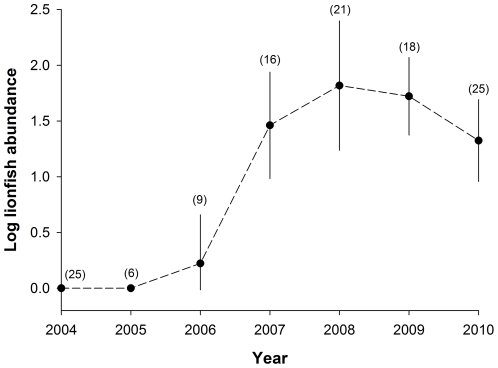
The abundance of Indo-Pacific lionfish (Pterois volitans and P. miles) on coral reefs off southwest New Providence, Bahamas.Abundance is the number of lionfish sighted during each roving survey, recorded in log10 scale. Points represent log-scale means, bounded by 95% confidence intervals. The yearly number of surveys is given in parentheses.